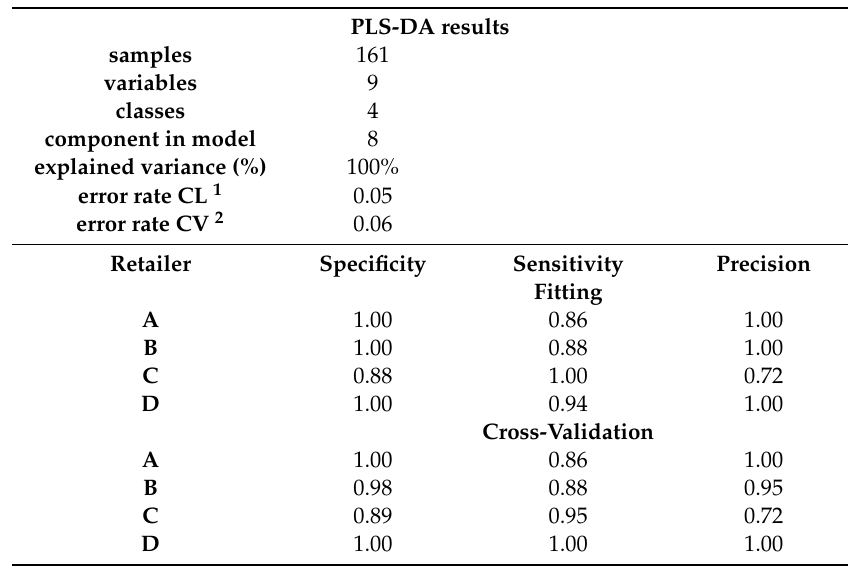
Table 3. PLS-DA classification results in fitting and cross-validation. Cross-validation ‘venetian blinds’ technique was used with the number of cv groups equal to 3. The optimal components for the model was previously calculated using the MatLab toolbox from Milano Chemometrics and Quantitative Structure Activity Relationship (QSAR) Research